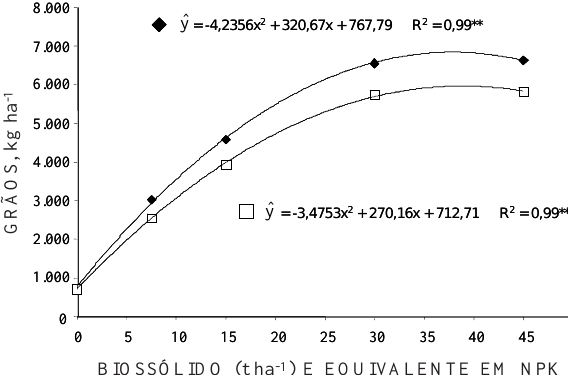
Figura 1. Efeito do biossólido ( ) e do fertilizante mineral misto ( ) na produtividade de grãos de milho. Média dos dois